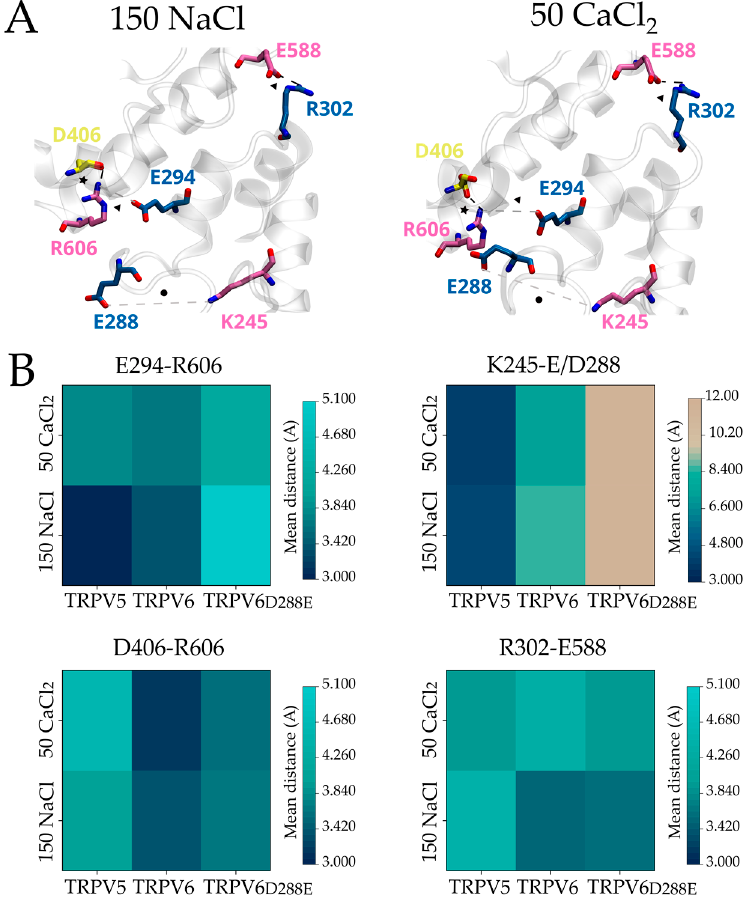
Figure 5. Calcium ions trigger structural changes within the HLH/S2-S3 linker/TDh inactivation motif in mutant TRPV6 channels. ( A ) Structural conformation of the three-dimensional HLH/S2-S3 linker/TDh inactivation motif of TRPV6–D288E after 100 ns of molecular dynamics simulations in presence of Na + or Ca 2+ ions. Residues of the HLH (blue), S2-S3 linker (yellow), TDh (mauve), and ARD6 (pink) contributing to interdomain interactions are highlighted, as well as the interactions (HLH/ARD: circle, HLH/TDh: triangle, S2-S3 linker: star). ( B ) Heat maps representing the average distance between the pairs of residues in panel A during the simulation time in TRPV5, TRPV6, and TRPV6-D288E. Bars on the right of each heat map represent the color scale of the mean distance during the simulation time.